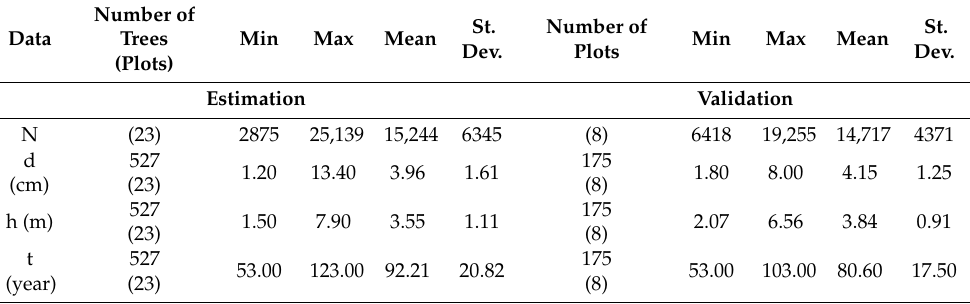
Table 11. Characterization of the datasets used to fit the SDE (1).